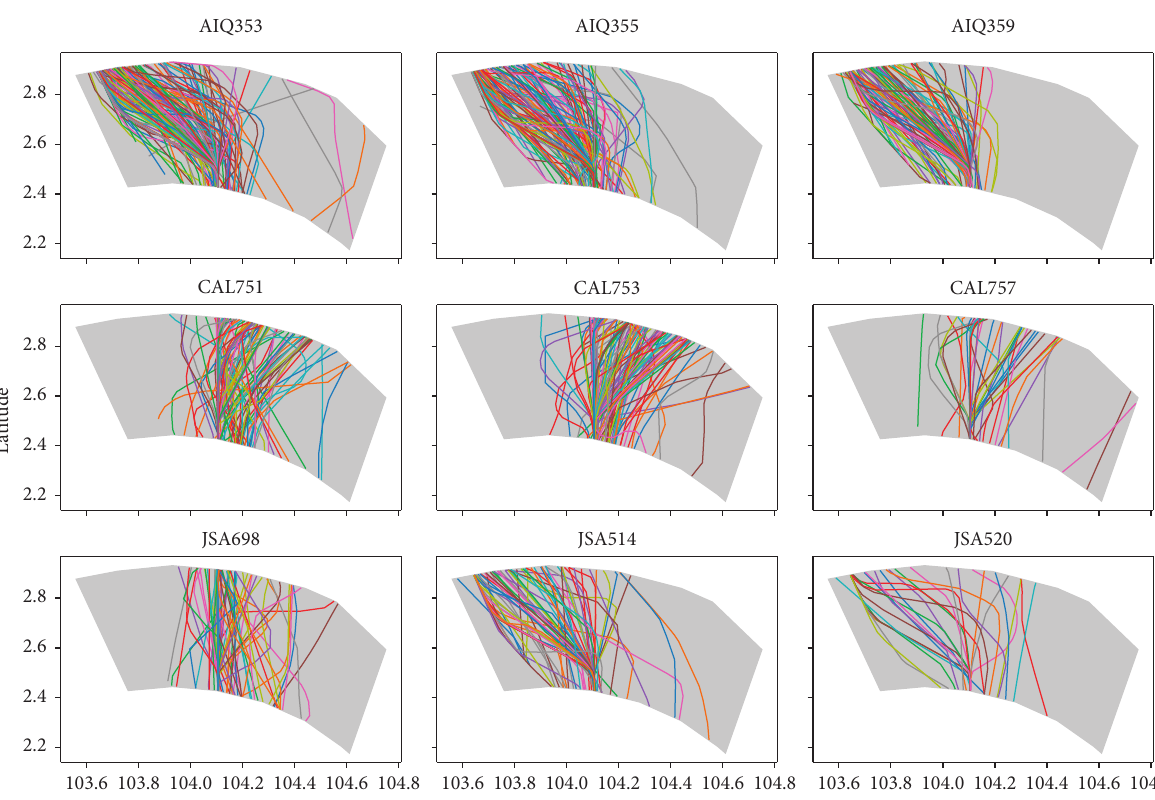
Figure 8: Each subplot is an example of multiple trajectories of the same flight’s identification passing sector 2E for landing at Singapore Changi Airport in our dataset. The flows come from the North to the South with various entry points and exit